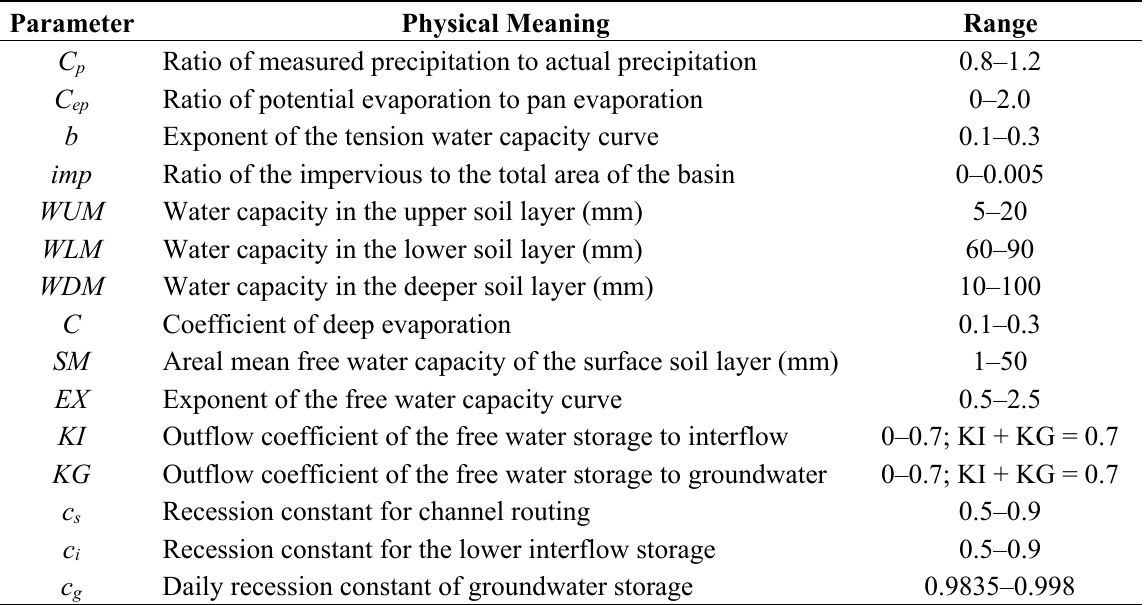
Table 2. Parameters in the Xinanjiang